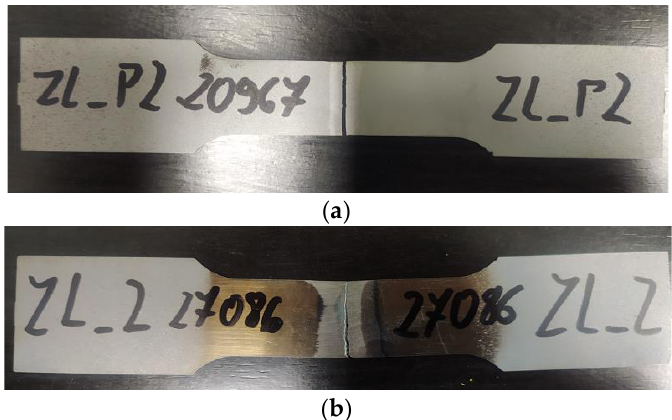
Figure 3. Load capacity of flash butt welded joints.